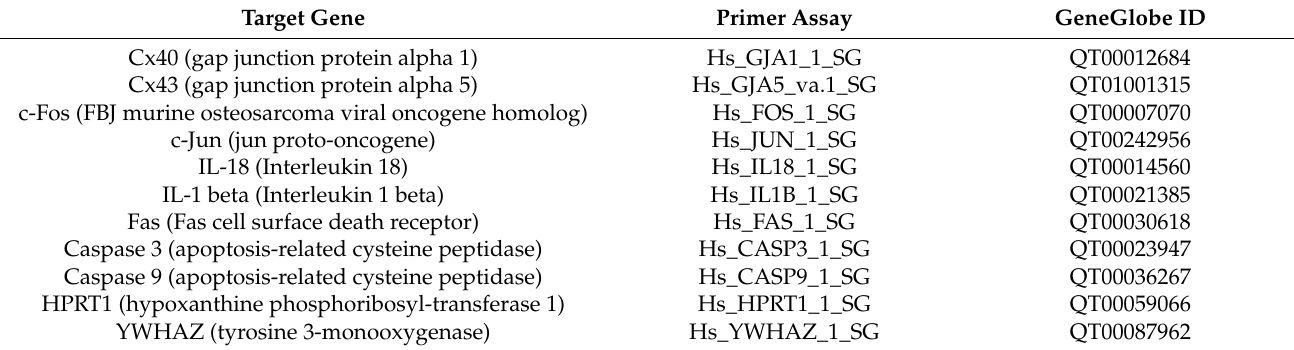
Table 3. Qiagen QuantiTect ® Primer Assays used for RTq-PCR. Target Gene Primer Assay GeneGlobe